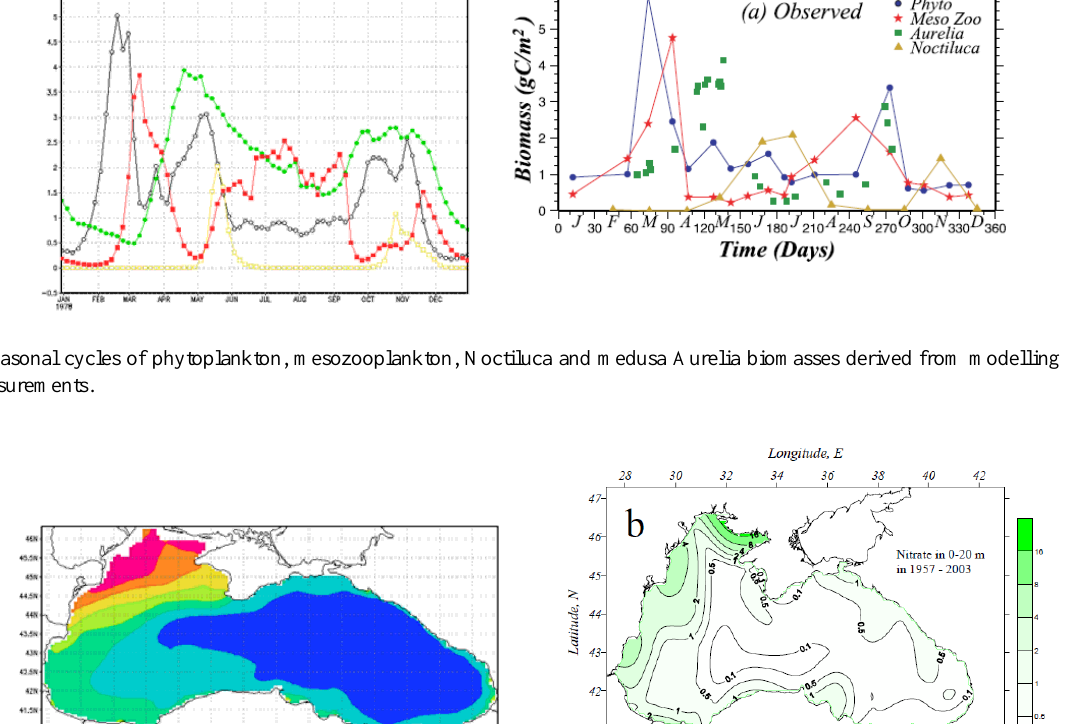
Figure 20 Evolution of the annual-mean phytoplankton biomass in the upper 50m layer for the deep part of the Black Sea basin. Figure 20 demonstrates evolution of the annual-mean phytoplankton biomass in the upper 50m layer for the deep part of the Black Sea basin. The phytoplankton biomass increases approximately twice from value about 1.2gC/m 2 in early seventies to 2gC/m 2 in mid nineties and then it decreases. These changes in the phytoplankton biomass can also be seen in evolution of the surface concentration. The phytoplankton community exhibits a major bloom during the late winter-early spring season, following the period of active nutrient accumulation